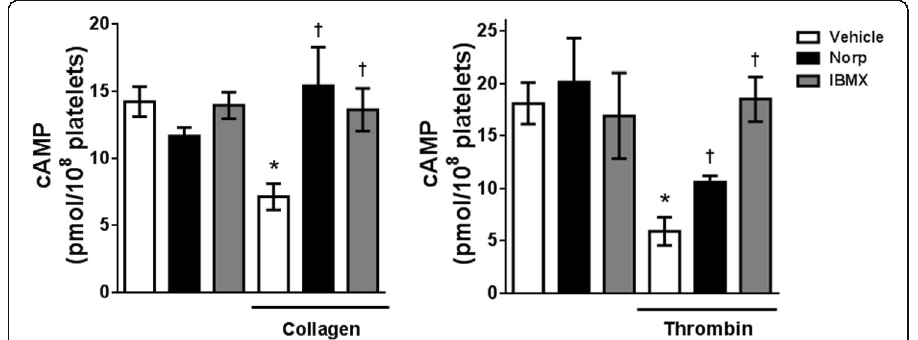
Fig. 7 Norpurpureine prevents the agonist-induced decrease in intra-platelet cAMP levels. Platelets were pre-treated for 10 min with vehicle (0.25% DMSO), 220 μ M norpurpureine and 10 μ M IBMX; and stimulated with 1 μ g/ml collagen (in platelet-rich plasma, PRP) and 0.075 U/ml thrombin (in washed platelets, WP). Data are the means ± SD ( n = 2, done in triplicate). p < 0.05 (*) compare to basal (PRP or WP) and p < 0.05 ( † ) compared to collagen- or thrombin-activated